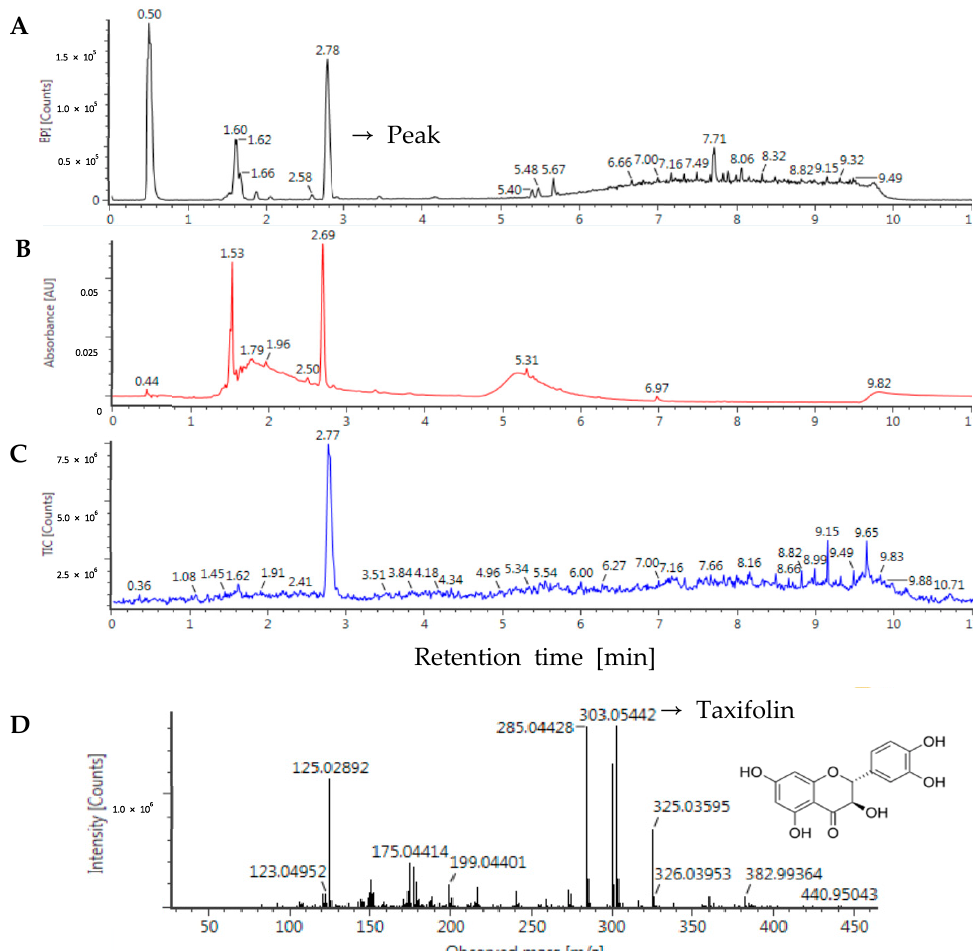
Figure 1. Chromatogram of sorghum ethanol extract obtained by ultra-performance liquid chromatography-electrospray ionization quadrupole time-of-flight mass spectrometry (UPLC-ESI-Q-TOF-MS). The total chromatogram of sorghum ethanol extract for ( A ) negative ion, ( B ) photodiode array (PDA) chromatogram, ( C ) the taxifolin standard, and ( D ) the fragmentation pattern.